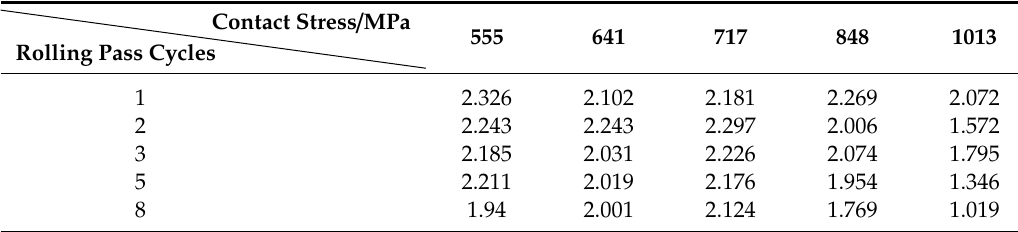
Table 4. Values of rolled specimen surface roughness/ μ m.